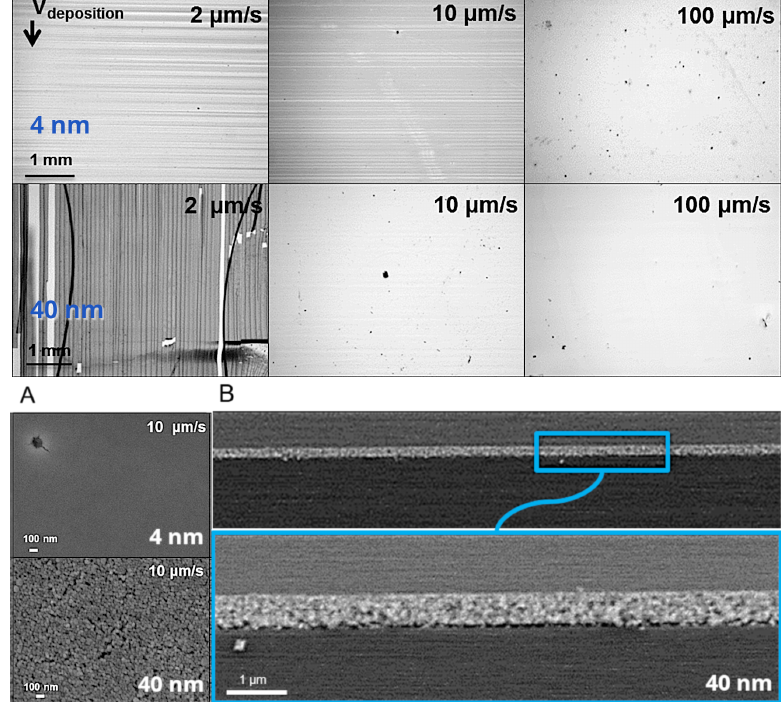
Figure 2. ( Top ): Representative optical microscopy images (bright field) for the coatings deposited at different deposition speeds using CeO 2 sols with nanoparticle size of 4 nm (first row) and 40 nm (second row); the morphologies of the coating are either with thickness oscillations and possible delamination, or flat (see also Figure 1 left). ( Bottom ): Scanning electron microscopy (SEM) (SEM-FEG HR JEOL 6700F) images of ( A ) the surface of coatings deposited at different speeds using CeO 2 sols with nanoparticle size of (top) 4 nm and (bottom) 40 nm and ( B ) of a cross-section of a coating deposited at 20 µ m.s − 1 (40 nm